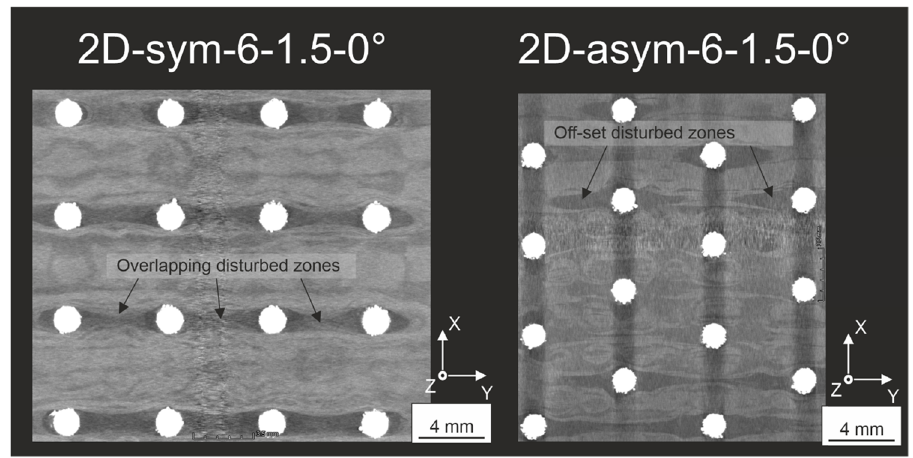
Figure 10: Comparison of 2D arrays with symmetric and asymmetric arrangement.